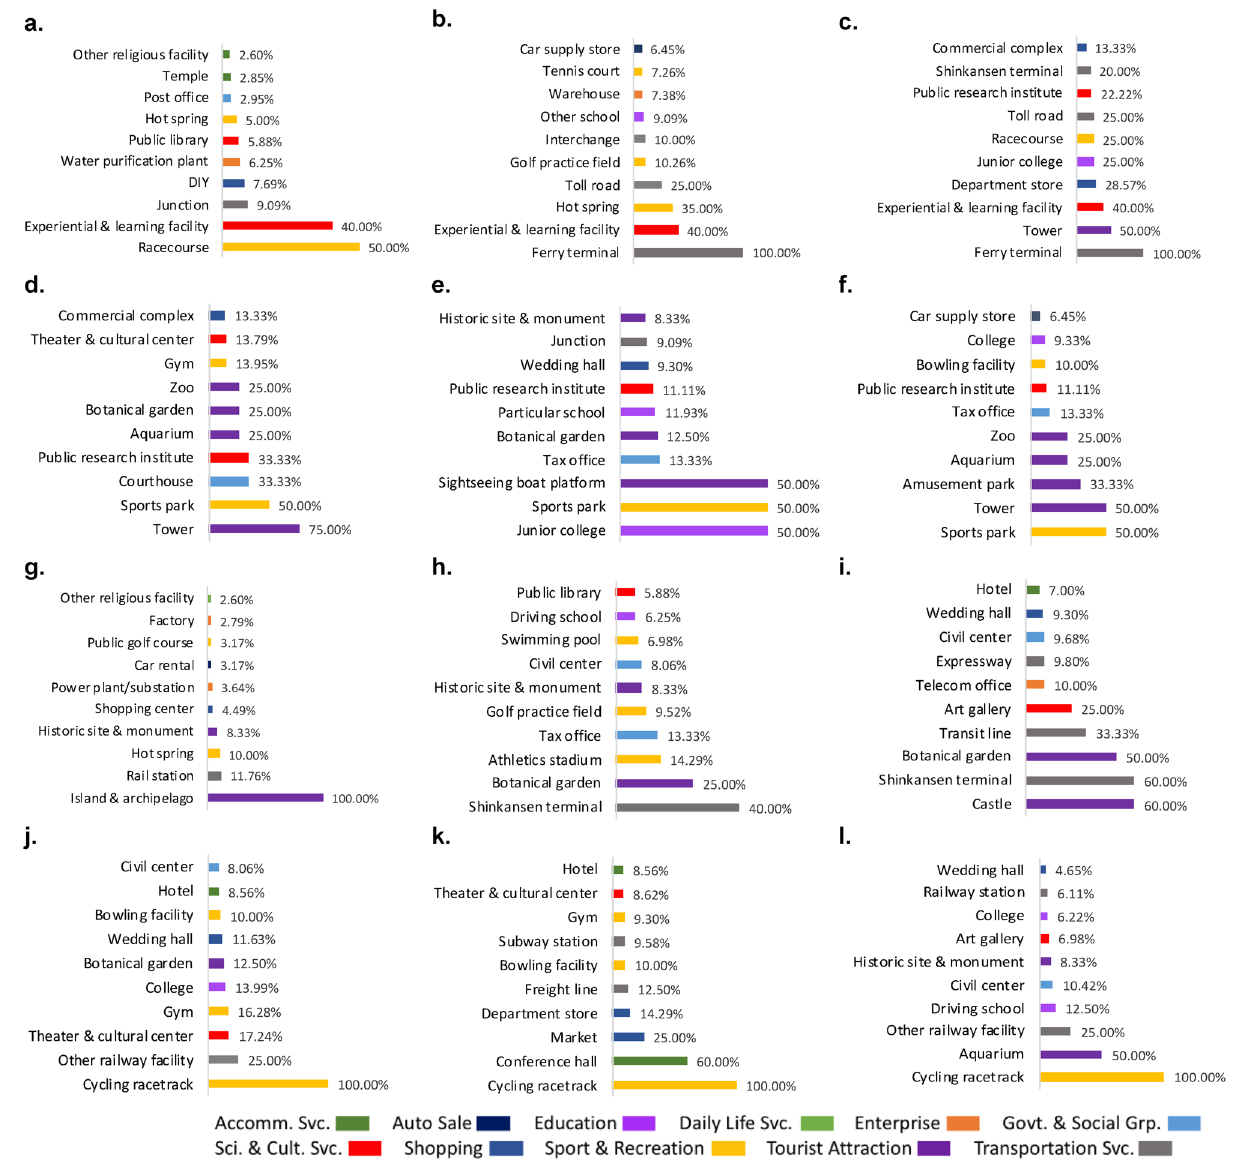
Figure 4. The top-10 most important POIs contributing to the urban recovery from COVID-19. ( a – c ) High- high type for working activity ( a ), night-life activity ( b ), and commercial activity ( c ). ( d – f ) Low-low type for working activity ( d ), night-life activity ( e ), and commercial activity ( f ). ( g – i ) Low-high type for working activity ( g ), night-life activity ( h ), and commercial activity ( i ). ( j – l ) High-low type for working activity ( j ), night-life activity ( k ), and commercial activity ( l ). Note: The value corresponding to each POI is the percentage of the POIs in its main agement is included. This study makes use of the benefits of high-resolution aerial images covering the whole area of a city and further applies deep learning methods to generate activation maps that are overlayed with vari- ous urban elements (including but not limited to urban land and facilities). Such analyses allow us to quantify the various associations of virtual features of aerial images with the urban recovery. In addition, no study has been done to examine the urban recovery from COVID-19 based on phone signaling data with 500 m × 500 m resolution covering the whole area of a city, by targeting main urban activities related to working (linked with employment), commercial activities (i.e., business), and night-life activities (i.e., discretionary activities). Fur- thermore, no study can be found to derive important urban facilities/services for the urban recovery by connect- ing with POIs and pre-pandemic socio-economic activities. Last but not the least, this research can be well dif- ferentiated from existing studies in terms of the joint use of CNN and Guided Grad-CAM, Elbow and K-means as well as BiLISA, which are suitable to deal with massive multi-source and multi-scale data, simultaneously.